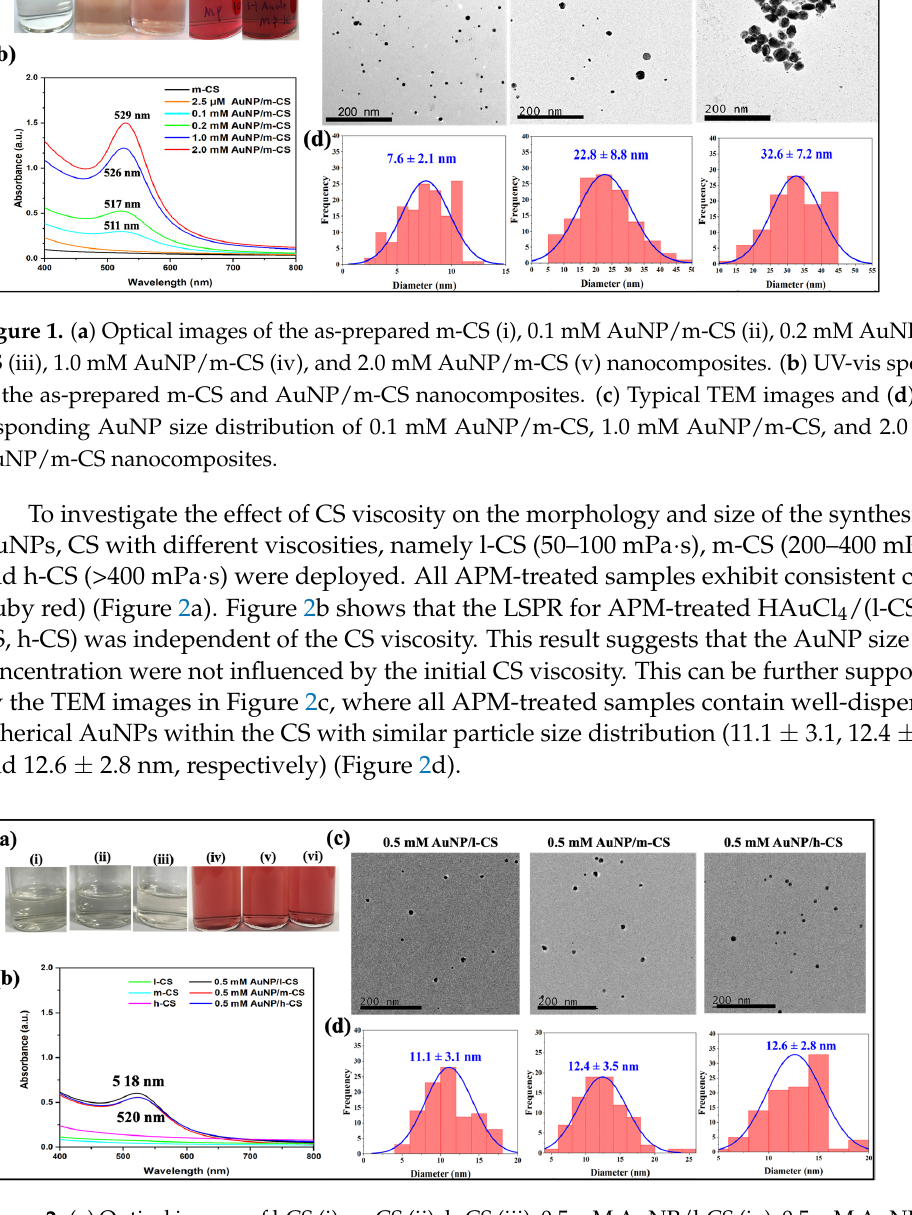
Figure 1. ( a ) Optical images of the as-prepared m-CS (i), 0.1 mM AuNP/m-CS (ii), 0.2 mM AuNP/m- CS (iii), 1.0 mM AuNP/m-CS (iv), and 2.0 mM AuNP/m-CS (v) nanocomposites. ( b ) UV-vis spectra